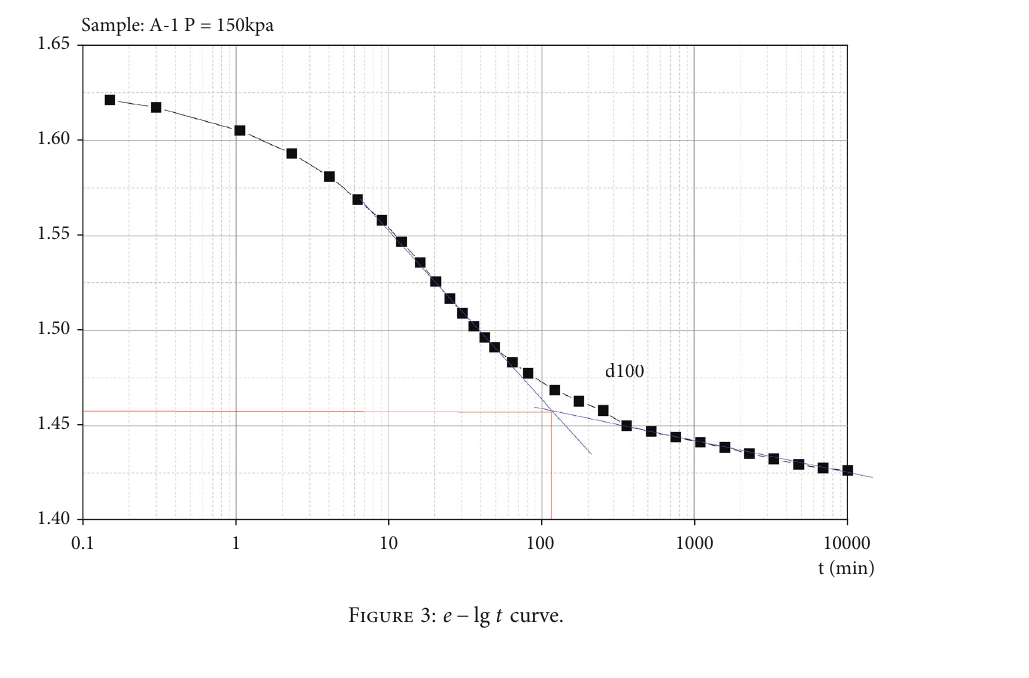
Figure 3: e − lg t